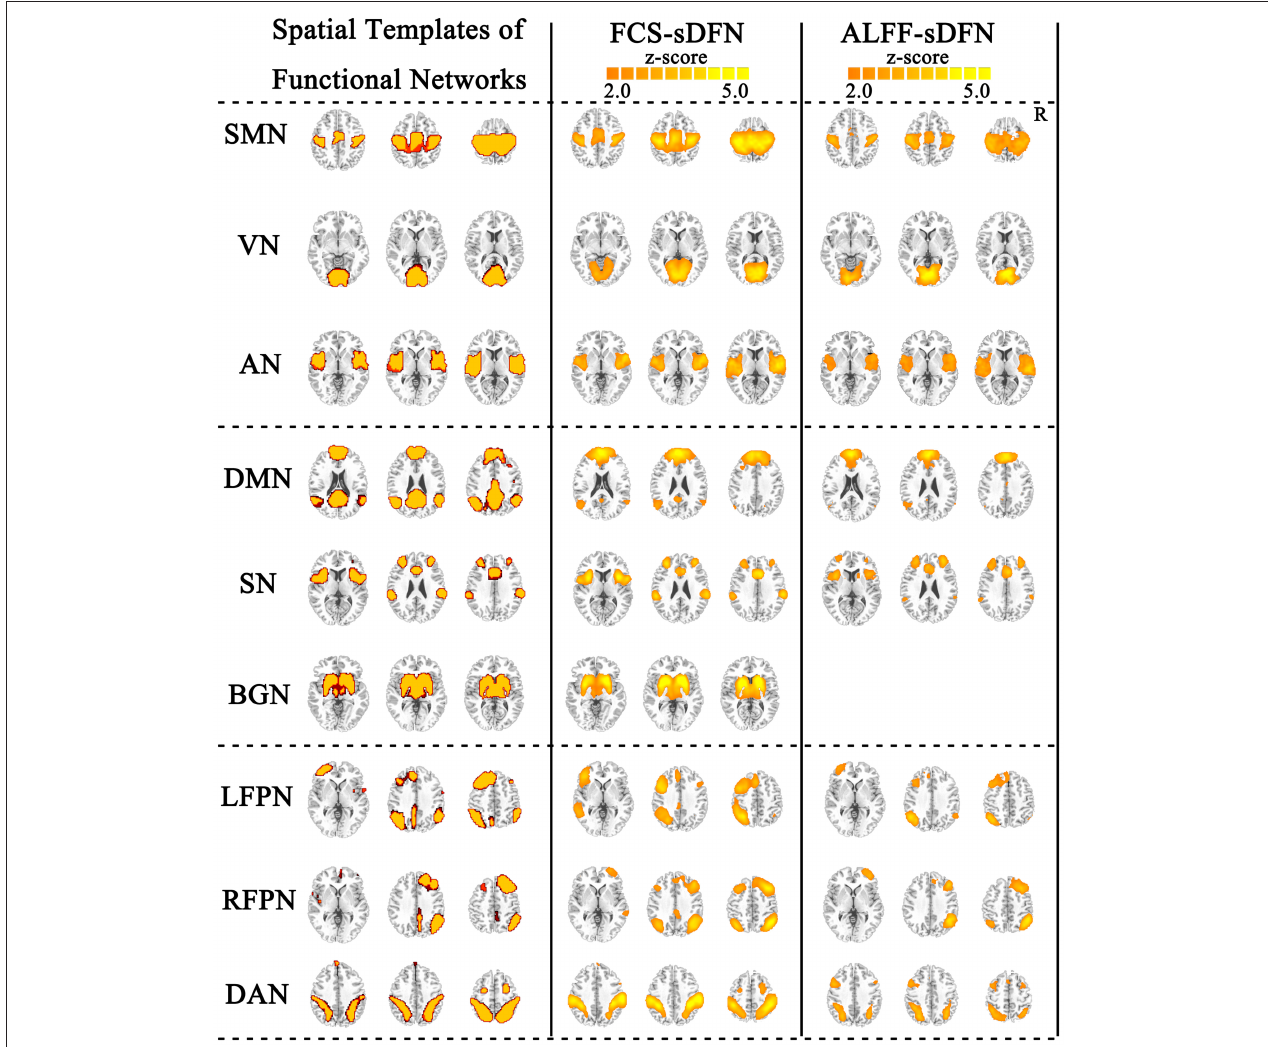
FIGURE 2 | Nine identified intrinsic spatial organization of dynamic functional networks (sDFNs). The first column includes the spatial template of nine resting-state functional networks (RSNs). The second and third columns denote the related FCS-sDFN and ALFF-sDFN, respectively. FCS, functional connectivity strength; ALFF, amplitude of low-frequency